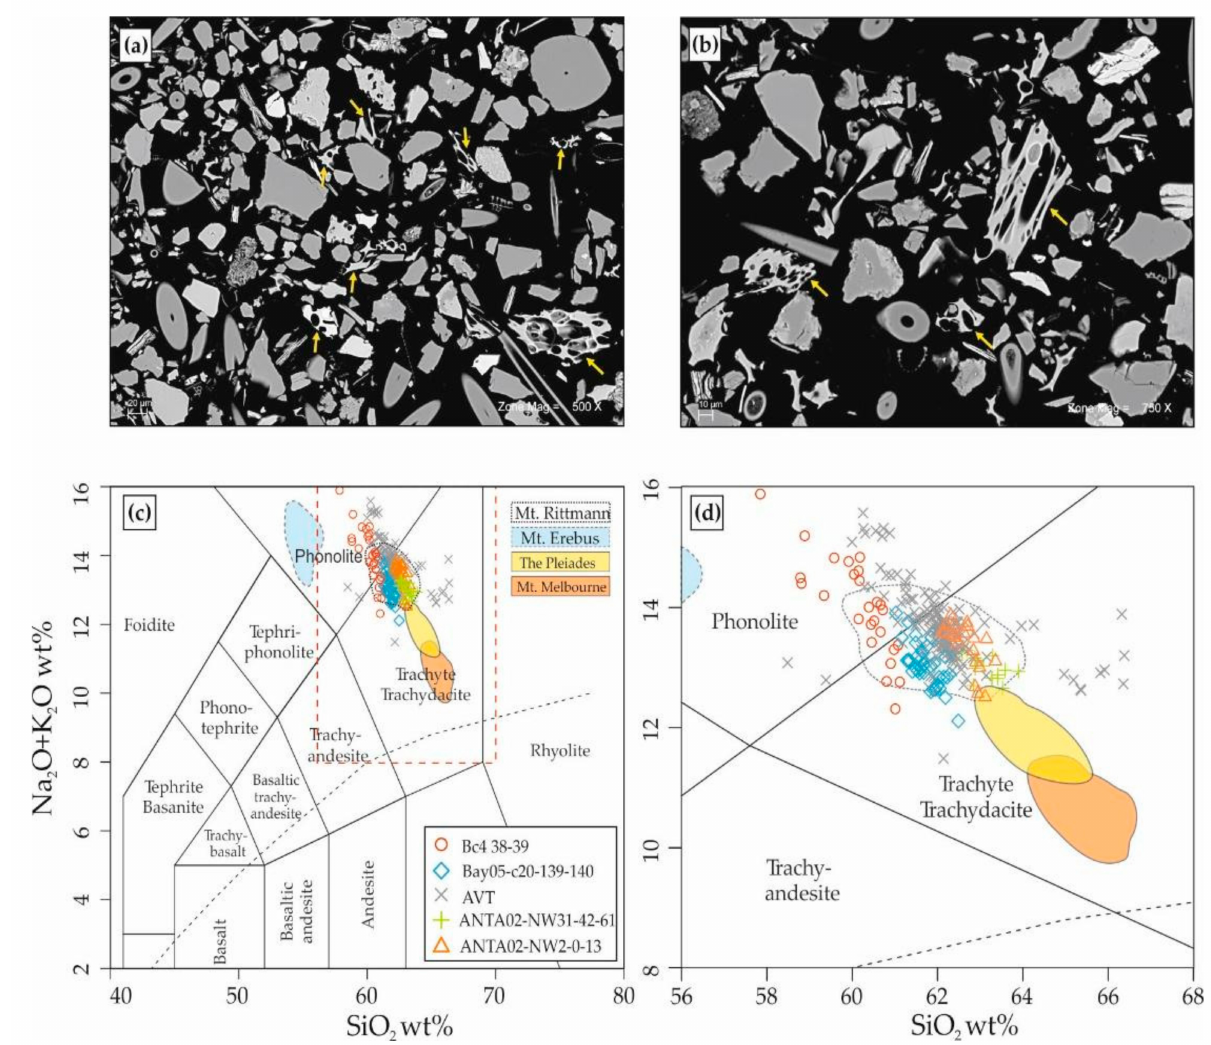
Figure 7. ( a , b ) SEM backscatter images of glass particles forming the BC4 38-39 crytotephra; ( c , d ) Total Alkali Silica (TAS; [56]) classification diagram showing individual glass shard composition in the BC4 38-39 cryptotephra and compared with available analyses of tephra and cryptotephra in the literature from other volcanic centres (Mount Rittmann: [57,58]; The Pleiades: [58]; Mount Melbourne: [58]; Erebus volcano: [59]). Bay05: [58]; AVT: [60]; ANTA02-NW2 and -NW31: